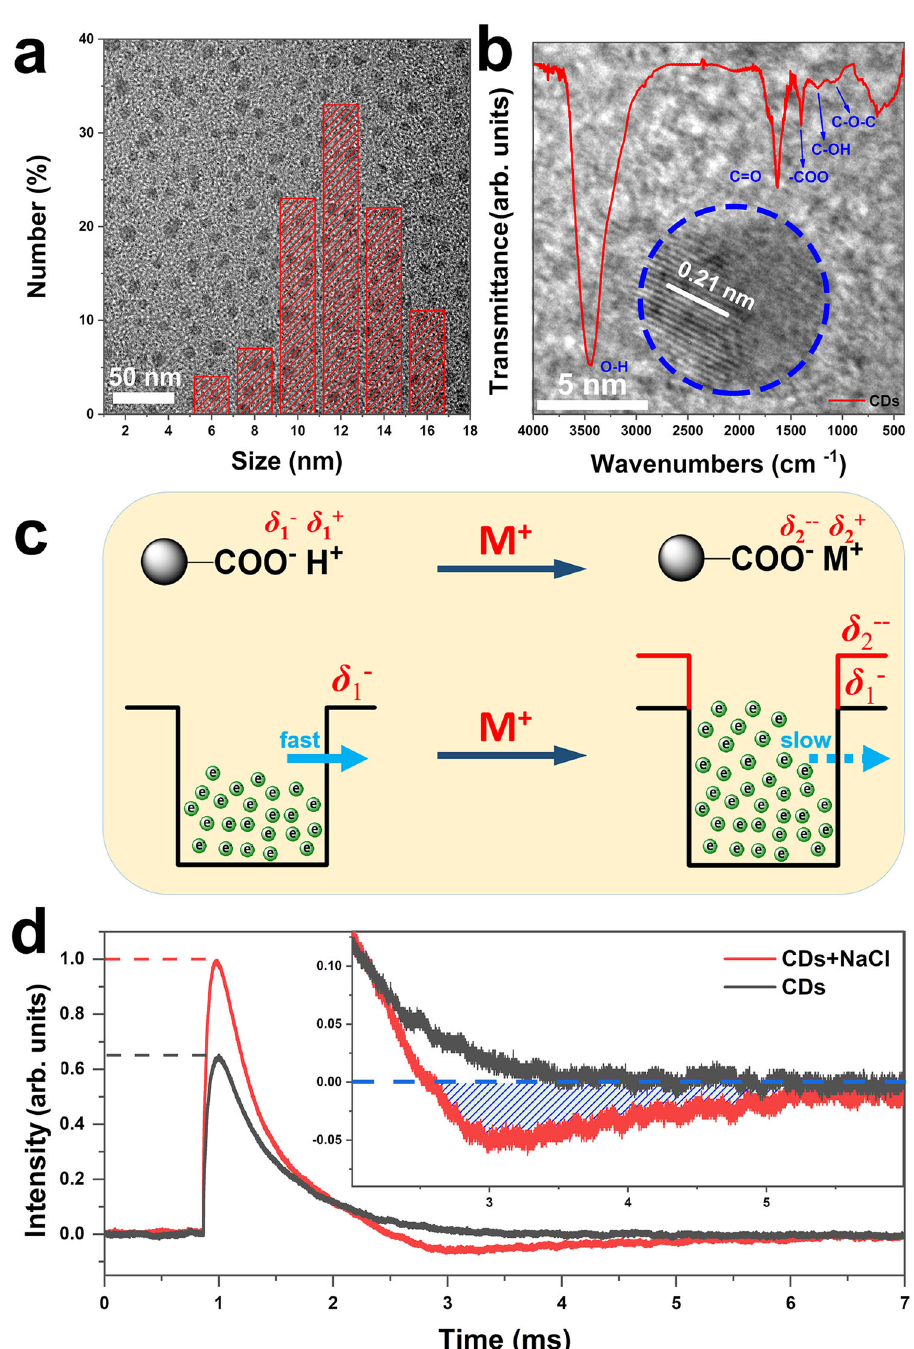
Fig. 2 Structure and property of CDs. a TEM image of CDs with the particle size distribution inserted. b HRTEM image of CDs with FT-IR spectrum inserted. c Schematic diagram of the electron sink model for CDs. The black boll represents a single CD, M + represents metal cations. d TPV curves of CDs powders before and after adding